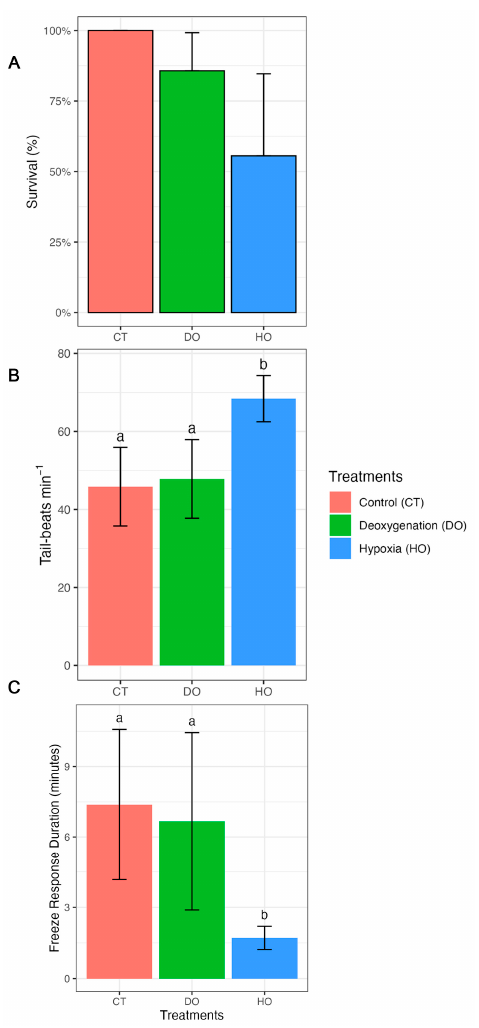
Figure 1. Effect of control (100% air saturation), deoxygenation (DO; 93% air saturation), and hypoxia (HO; 26% air saturation) on survival ( A ), tail beat rate ( B ), and freeze response duration ( C ) of S. canicula embryos. Different lower-case letters indicate statistically significant differences between experimental treatments. Table 2. Summary output for generalized linear models of shark embryos’ survival, average number of tail beats, and freeze response duration among control, deoxygenation, and hypoxia treatments. Statistical signi fi cance at p -value < 0.05 is shown in bold.